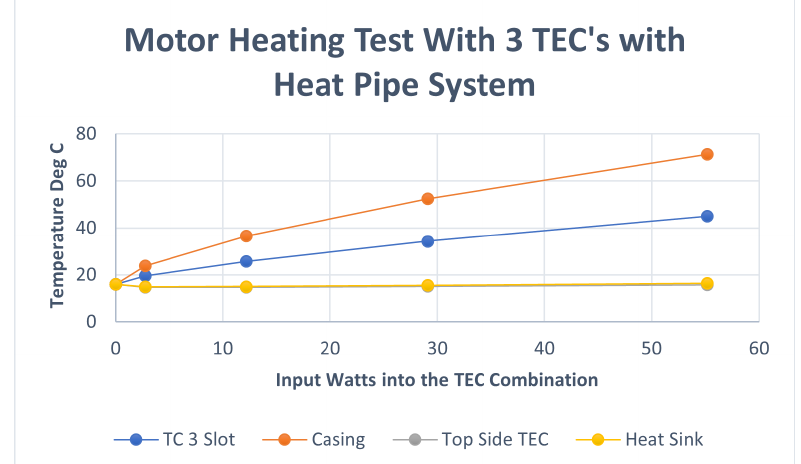
Figure 13. The graphed results of the heating with the TECs and heat pipe coolers.